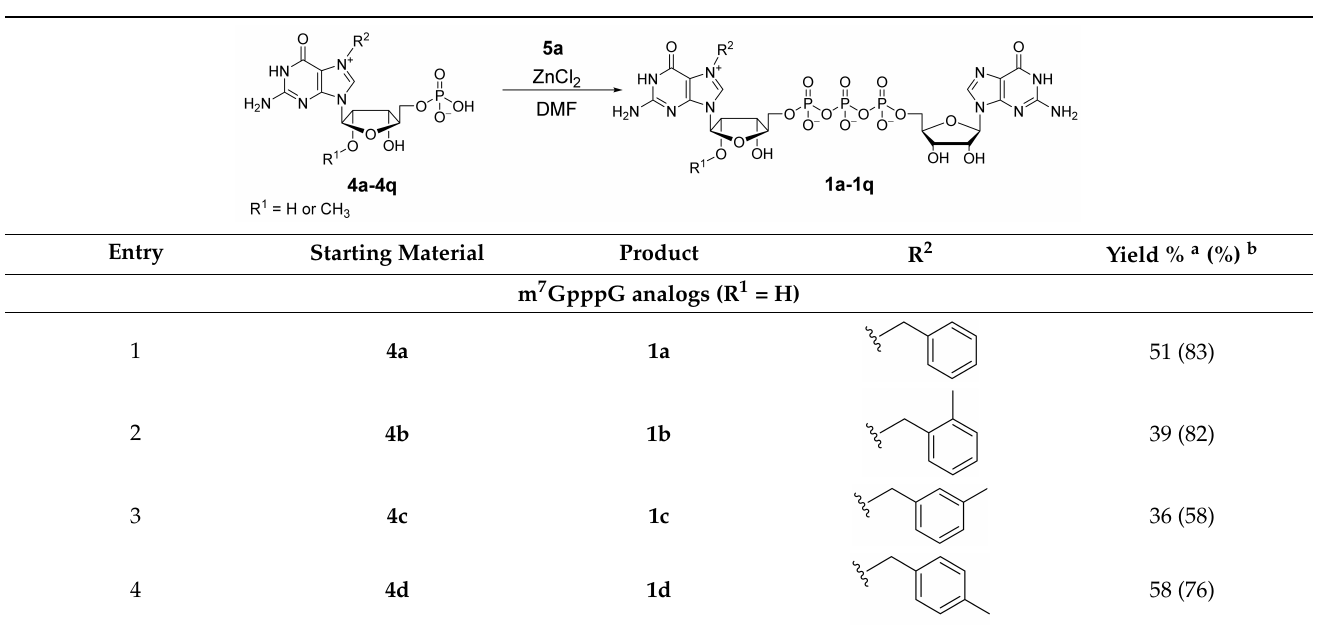
Figure 2. Representative RP HPLC profiles from the synthesis of 1h and 1f. ( A ) Synthesis of 1h . Bottom: purified 4h (4-Cl-Bn 7 GMP), middle: reaction mixture after 1 h, top: the final product ( 1h ) after HPLC purification. ( B ) Synthesis of 1f . Bottom: purified 4f (3,5-di-MeBn 7 GMP), middle: reaction mixture after 1 h, top: the final product ( 1f ) after HPLC purification. Table 1. Reaction yields for cap analogs 1a – 1r